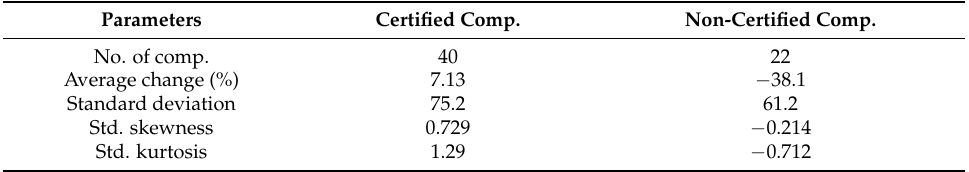
Table 4. Summary statistics on the change in fossil fuel efficiency improvement in the period 1997–2003.